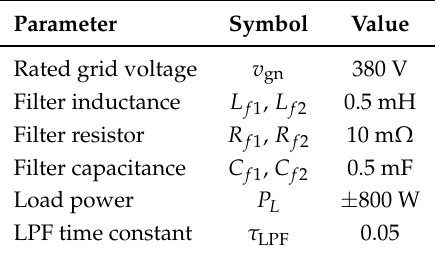
Table 4. DC microgrid simulation parameters. LPF: low-pass filter.